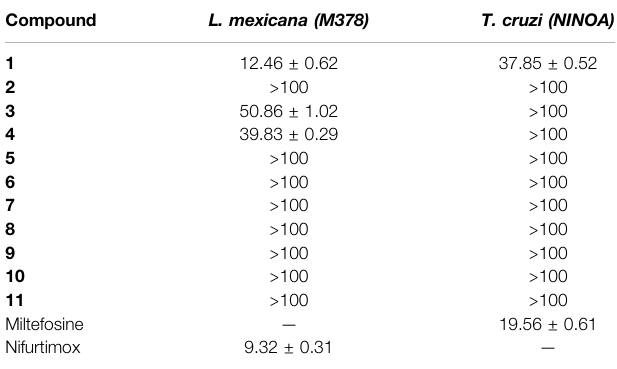
TABLE 2 | IC 50 (µM ± SD)ofthe benzopyrazine( 1 – 11 )against epimastigotes from T. cruzi and promastigote from L. mexicana . Compound